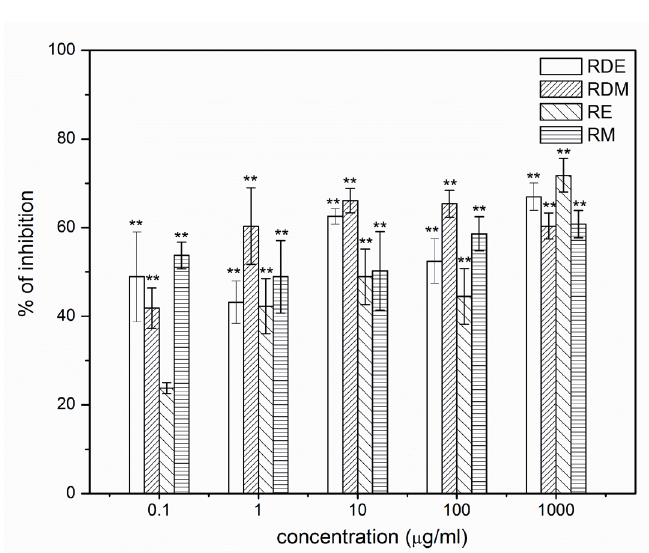
Fig. 3: Cytostatic activity of different Ruta graveolens samples (RM – methanolic extract of wild growing plants, RDM – methanolic extract of cultured plants, RE – ethanolic extract of wild growing plants, RDE – ethanolic extract of cultured plants) on HeLa cells (% of inhibition) after 72 h of incubation. Differences of the effects of different rue extracts in different concentrations to untreated con- trol were checked using t-test, significant differences p<0.001 being marked with (**).